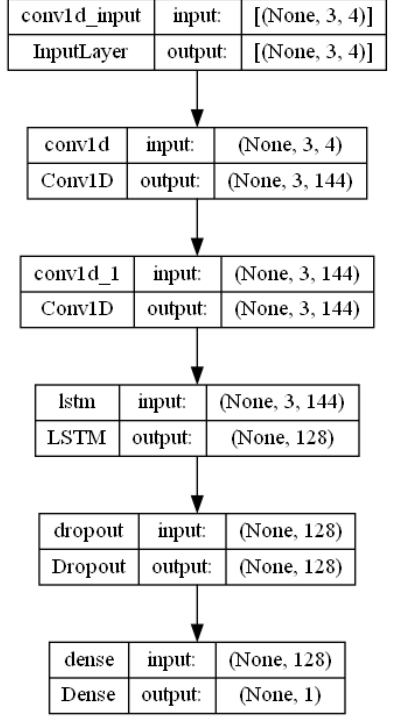
Figure 7. Proposed CNN-LSTM, model architecture parameter. Table 1. Model parameter table.